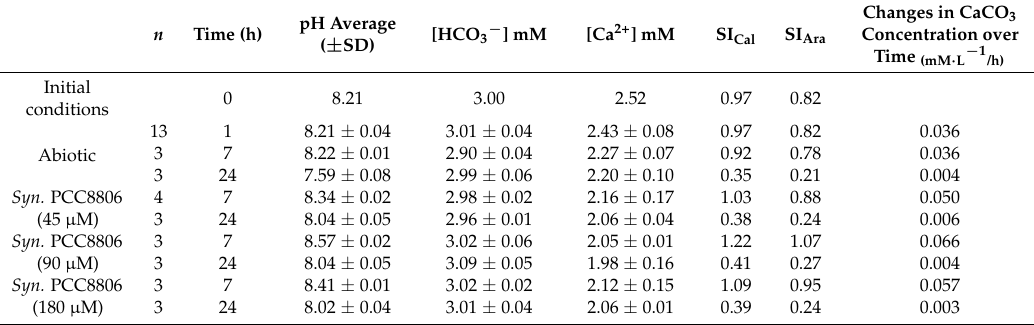
Table 4. Summary of the precipitation experiments results.